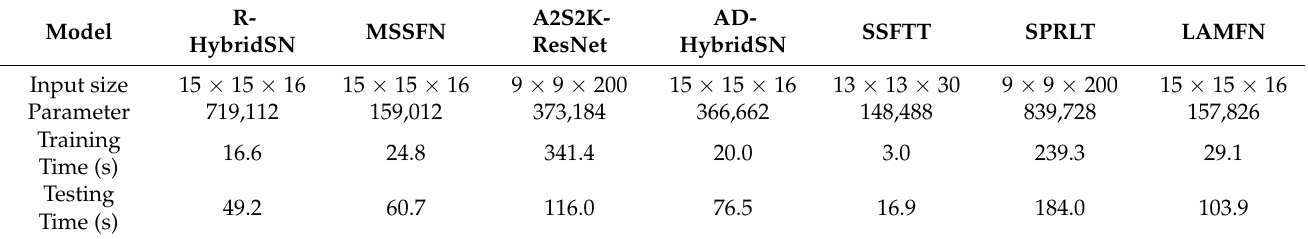
Table 7. Running related parameters of the LAMFN and the contrast